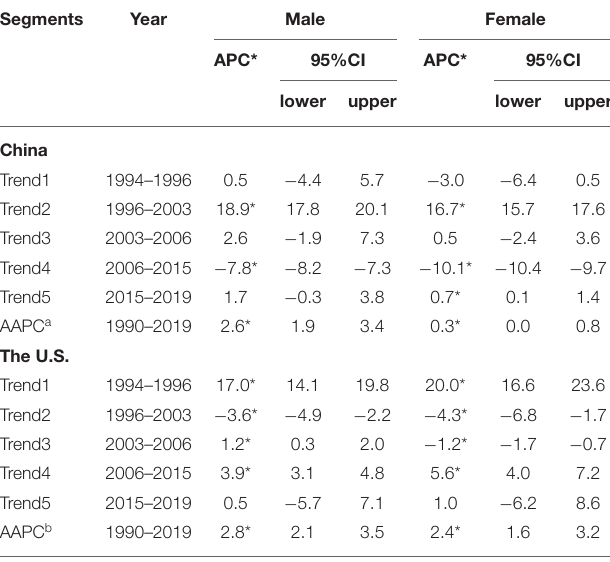
TABLE 1 | Trends in HIV ASIR by gender in China and the U.S.,